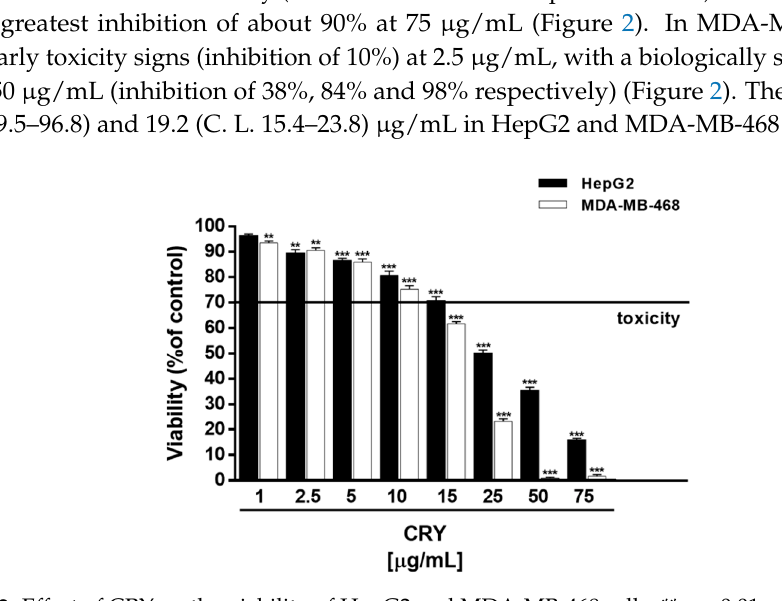
Figure 2. Effect of CRY on the viability of HepG2 and MDA-MB-468 cells. ** p < 0.01 and *** p < 0.001 (analysis of variance (ANOVA) + multiple Dunnett’s comparison post-test); denotes a statistically significant reduction of cell viability compared to control (i.e., vehicle-treated cells). A cell viability lower than 70% respect to control was considered as cytotoxic [26].